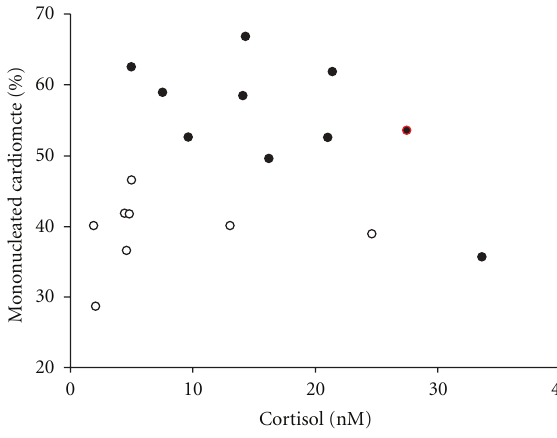
Figure 8: There is no relationship between fetal plasma cortisol concentration and the percentage of mononucleated cardiomy- ocytes in either control (open circles) or PR (closed circles, carun- clectomy model of IUGR in sheep) sheep